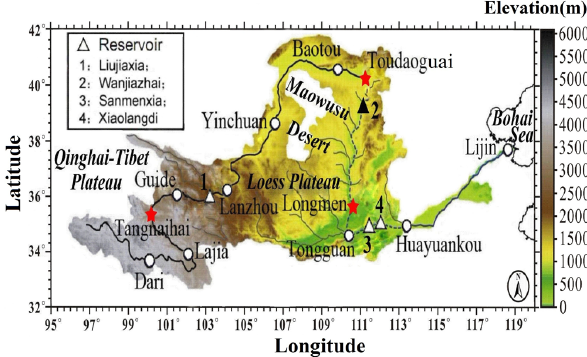
Fig. 1. Map of the Yellow River basin, which consists of two main geographical units, the Qinghai–Tibetan Plateau and the Loess Plateau (quoted from Wang et al., 2010). Sampling stations are in- dicated by open symbols. Wanjiazhai reservoir (marked as 2) is one of the most important sites for the water and sediment regulation scheme. Red stars denote additional hydrological stations, whose discharge data are also used (see text for